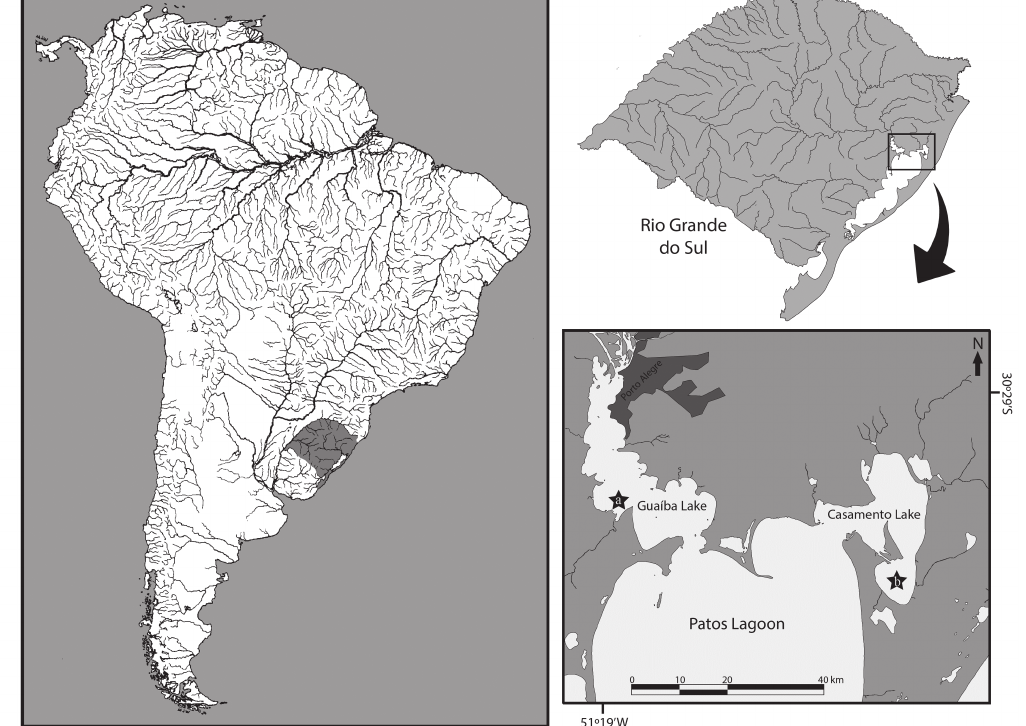
Fig. 1. Sampling locations in a. Guaíba Lake and b. Casamento Lake in Rio Grande do Sul, southern